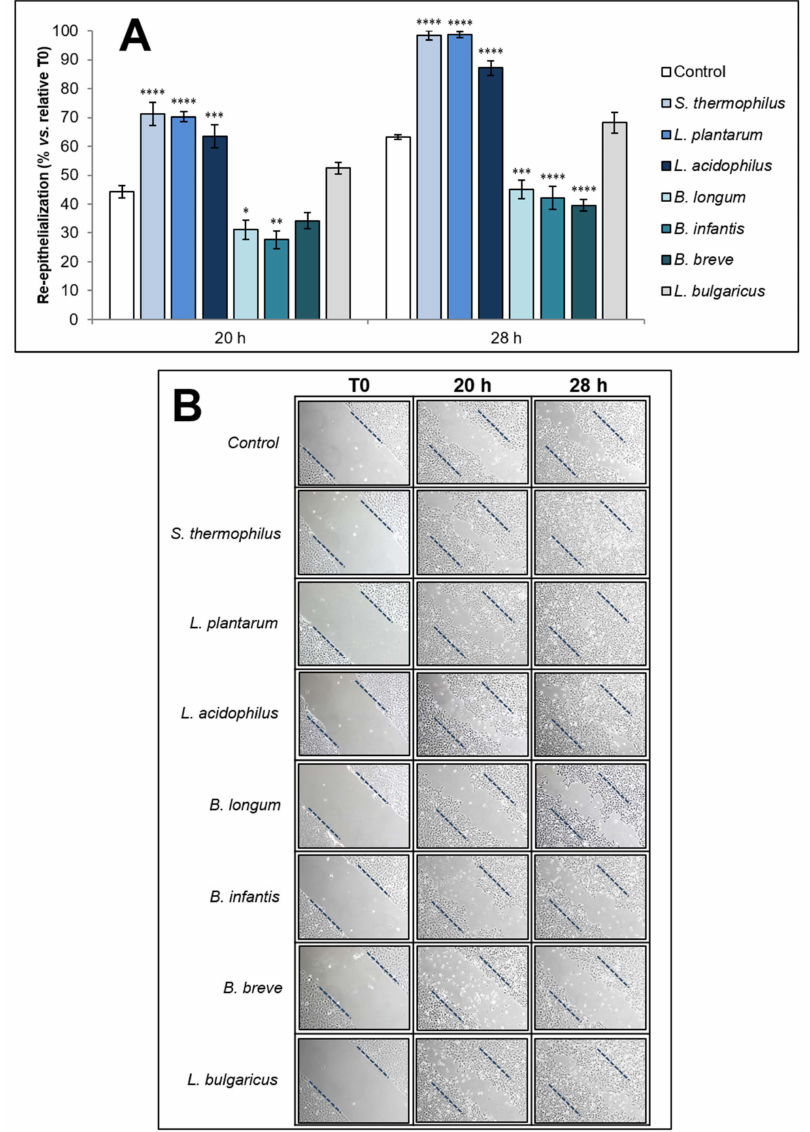
Figure 1. E ff ect of the soluble fraction of bacterial lysates on re-epithelialization of HaCaT cell line scratched monolayers at di ff erent time points. ( A ) E ff ect of bacterial samples (50 µ g / mL) on the wound closure rate (% vs. relative T0) of scratched monolayers at 20 and 28 h. Data are expressed as mean ± SEM of three independent experiments in duplicate. For comparative analysis of groups of data, a two-way analysis of variance (ANOVA) with post hoc Dunnett test was used. * p < 0.05, ** p < 0.01, *** p < 0.001, **** p < 0.0001 vs. control (untreated). ( B ) Representative images of HaCaT monolayer re-epithelialization in the absence (control) or presence of bacterial samples (50 µ g / mL) at 20 and 28 h after injury (10 ×